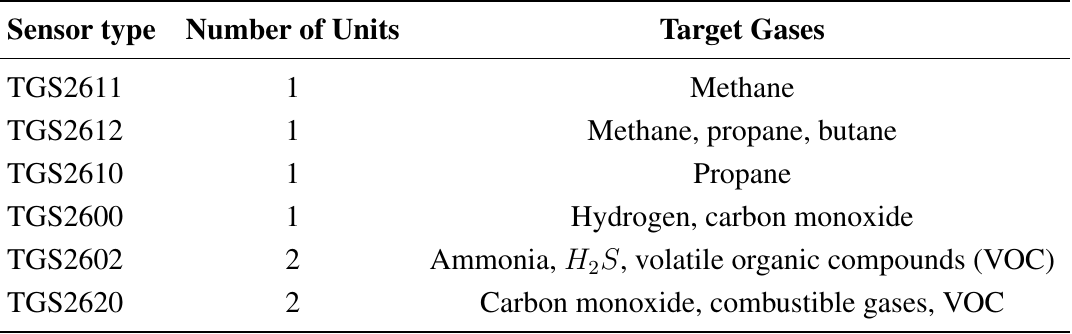
Table 1. Metal oxide (MOX) sensors included in the sensing unit.